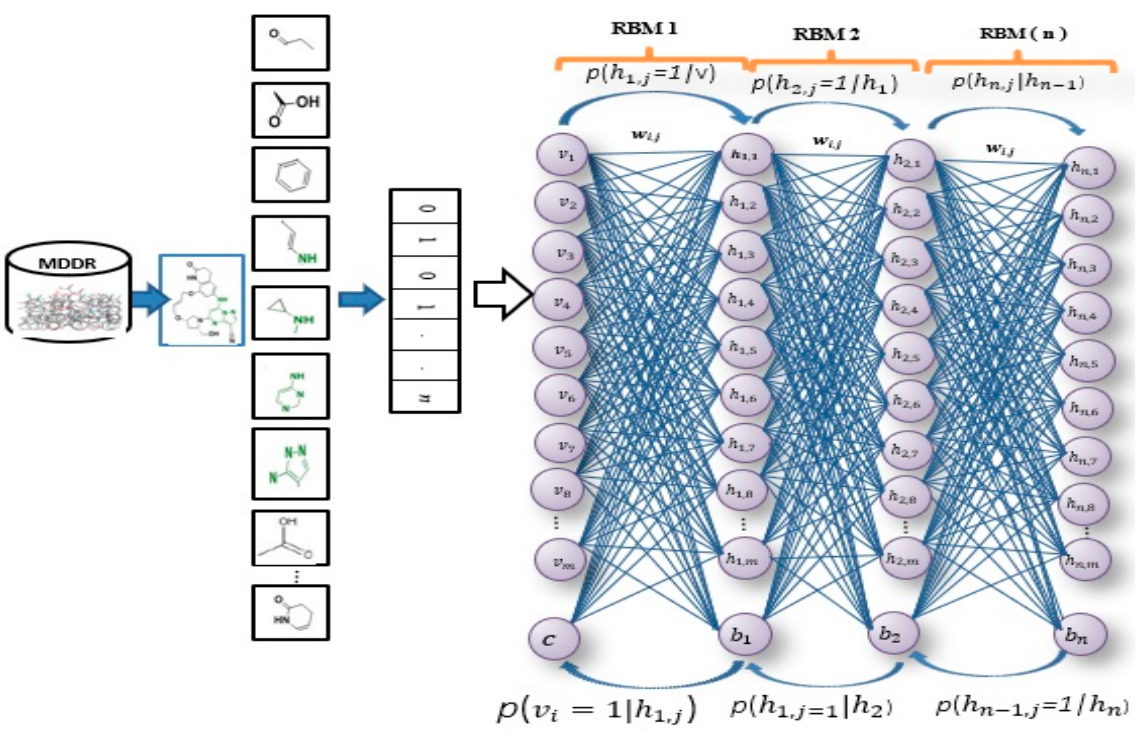
Figure 1. Deep belief networks (DBN) Architecture.